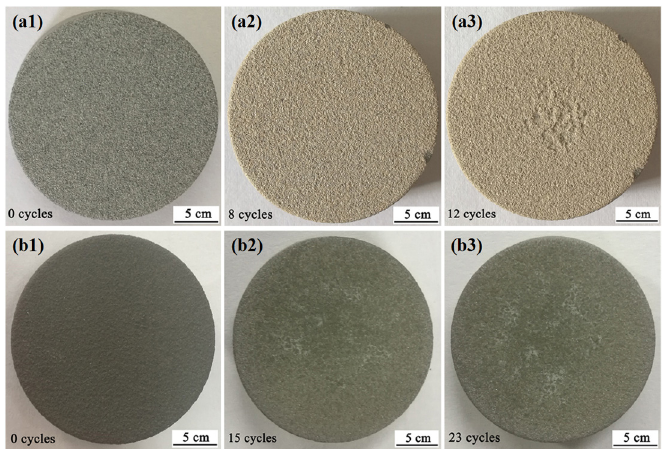
Figure 11. Digital photographs during the thermal shock cycling of the as-sprayed coatings: ( a1 ) O C 0 cycles, ( a2 ) O C 8 cycles, ( a3 ) O C 12 cycles, ( b1 ) N C 0 cycles, ( b2 ) N C 15 cycles, ( b3 ) N C 23 cycles